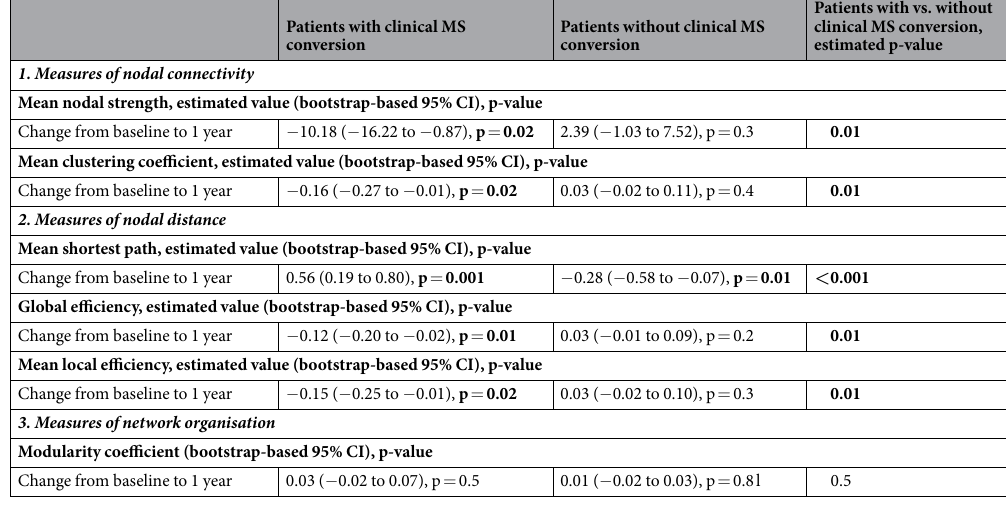
Table 3. One-year changes in SCN parameters, in CIS patients with and without clinical conversion to MS. Comparison between patients with and without MS conversion was made looking at the 95% CI. See main text for full details on the methods used. Significant p-values are indicated with bold letters. Abbreviations: CI: confidence interval; CIS: clinically isolated syndrome; FU: follow-up; HCs: healthy